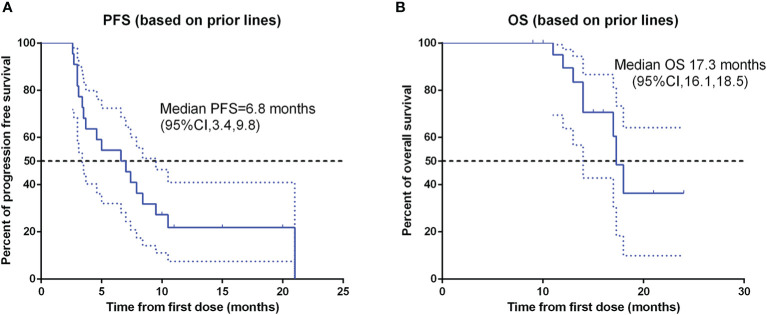
Kaplan-Meier survival curve of progression-free survival (A) and overall survival (B) in 22 non-small cell lung cancer patients. PFS, progression-free survival; OS, over survival; CI, confidence interval.